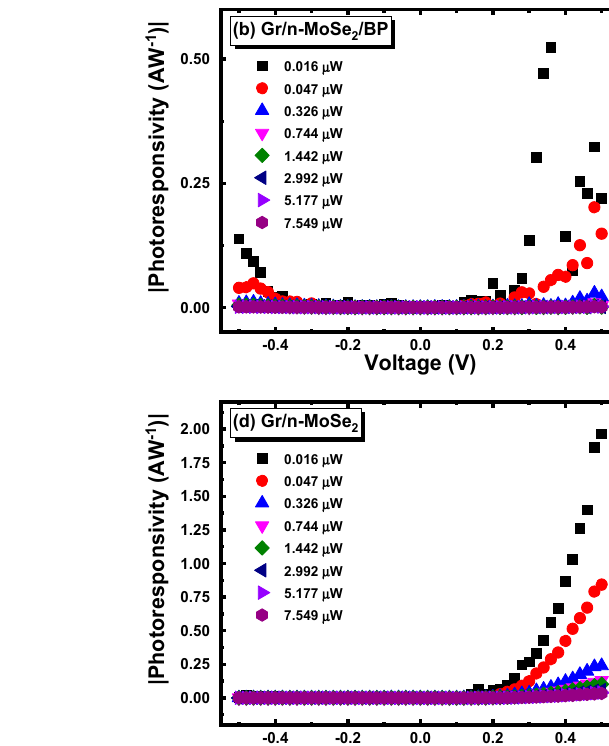
as I d = I S ( exp ( qV d / nk B T ) − 1), where I S is the reverse saturation current, q the elementary